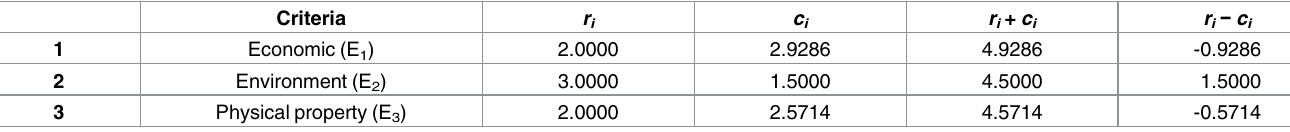
Table 6. Sum of the influences given and receivedregarding the dimensions.